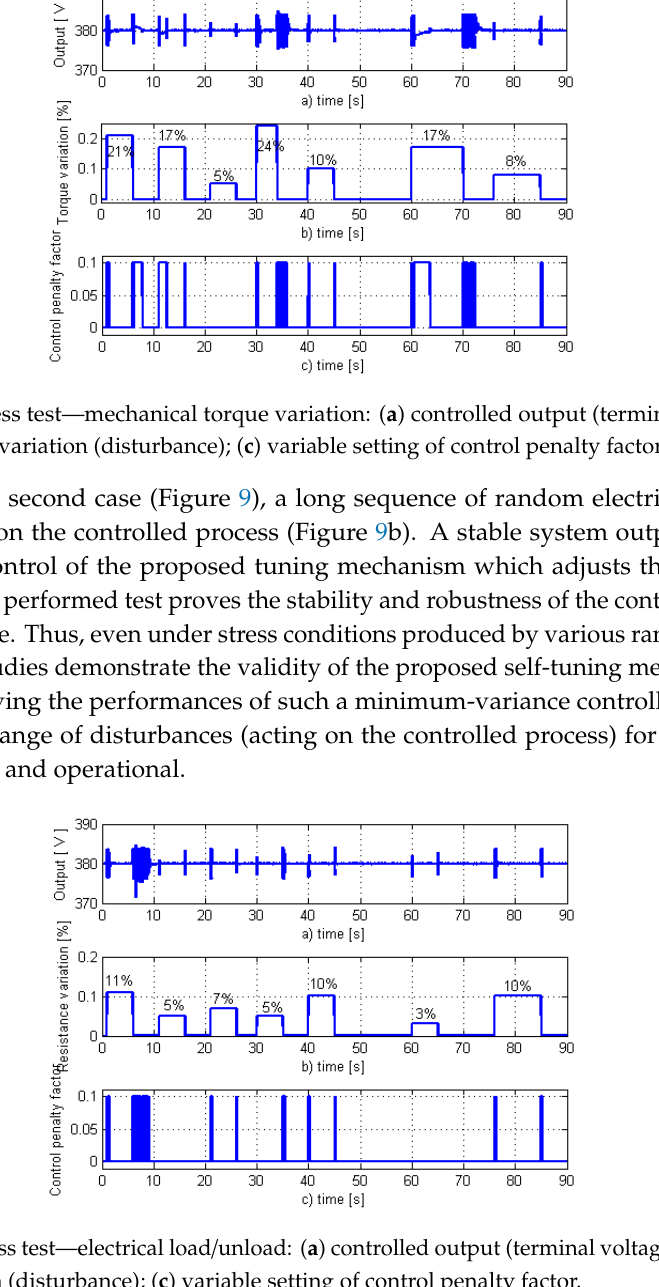
(b) Figure 10. (a) Controlled output—minimum variance controller (( (cid:2025) = 0.1, (cid:1986)(cid:1846) (cid:3040) = 10%) , small disturbance); ( b) Controlled output—classical PID controller (( (cid:1986)(cid:1846) (cid:3040) = 10% ) , small disturbance)